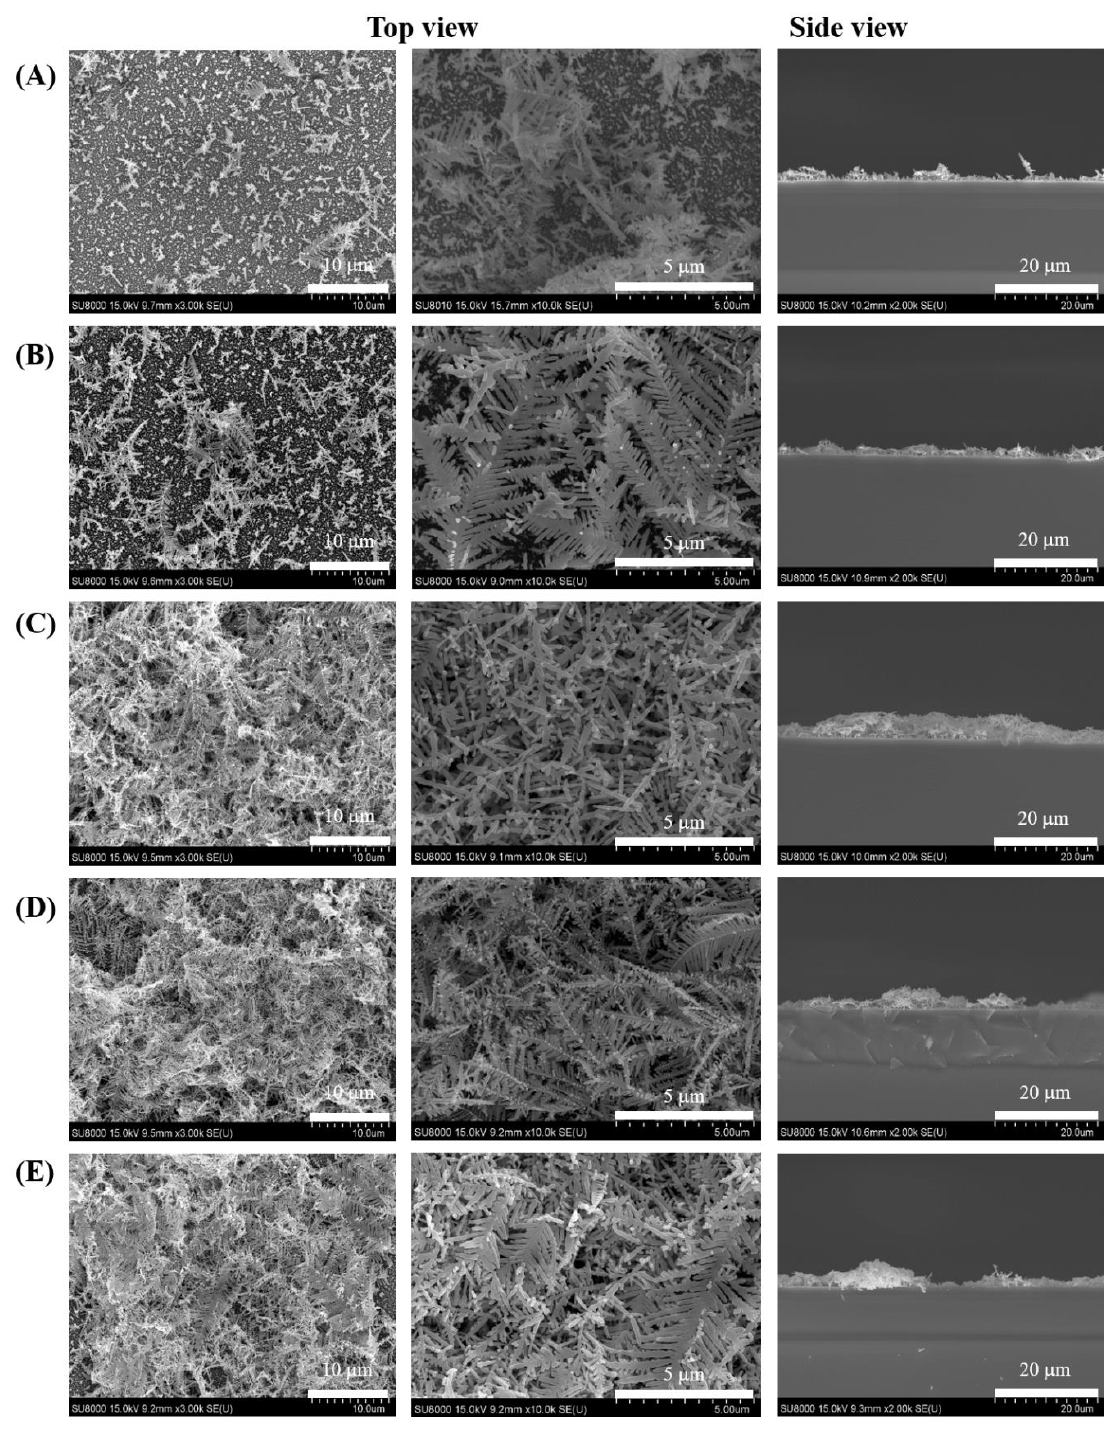
Figure 6. Representative SEM images of the Ag nanostructures prepared with various volume ratios of BOE to deionized water: ( A ) 0.083, ( B ) 0.167, ( C ) 0.33, ( D ) 0.67, and ( E ) 1.00×. Scale bar: 10 µm, 5 µm (top view) and 20 µm (side view).